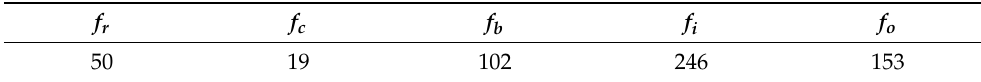
Table 2. The fault characteristic frequencies of the test rolling bearing.